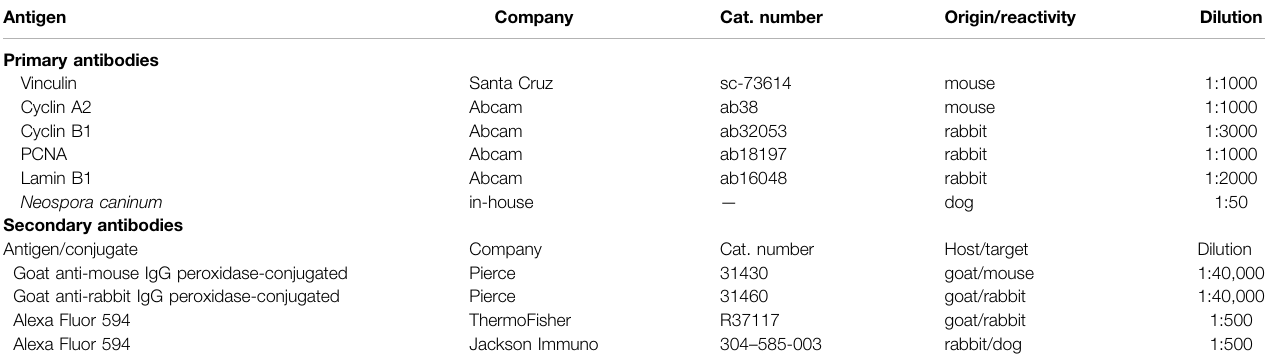
TABLE 1 | Primary and secondary antibodies used in the current study.